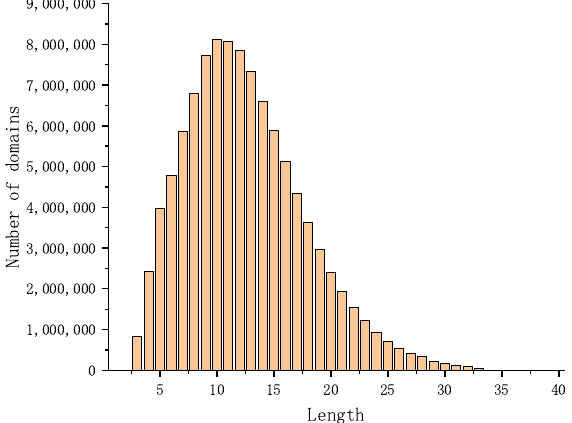
Figure 2. Distribution of lengths of all the registered .com domains.